Question: What kind of plot is shown here?
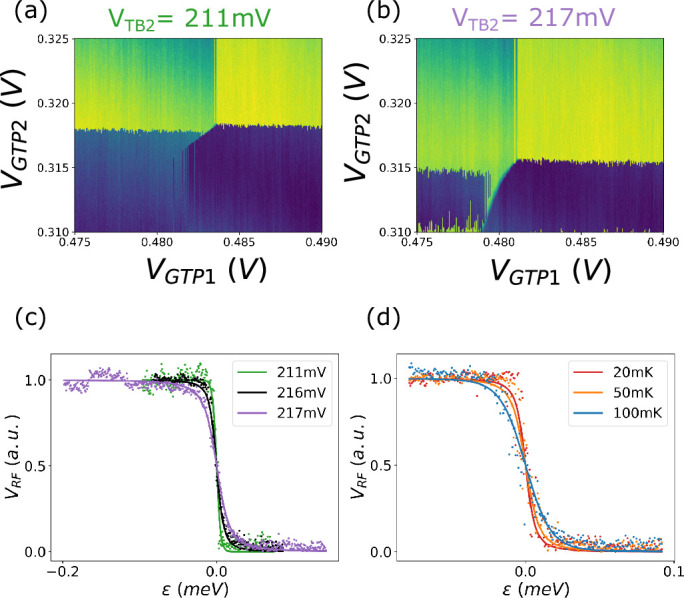
Answer: line